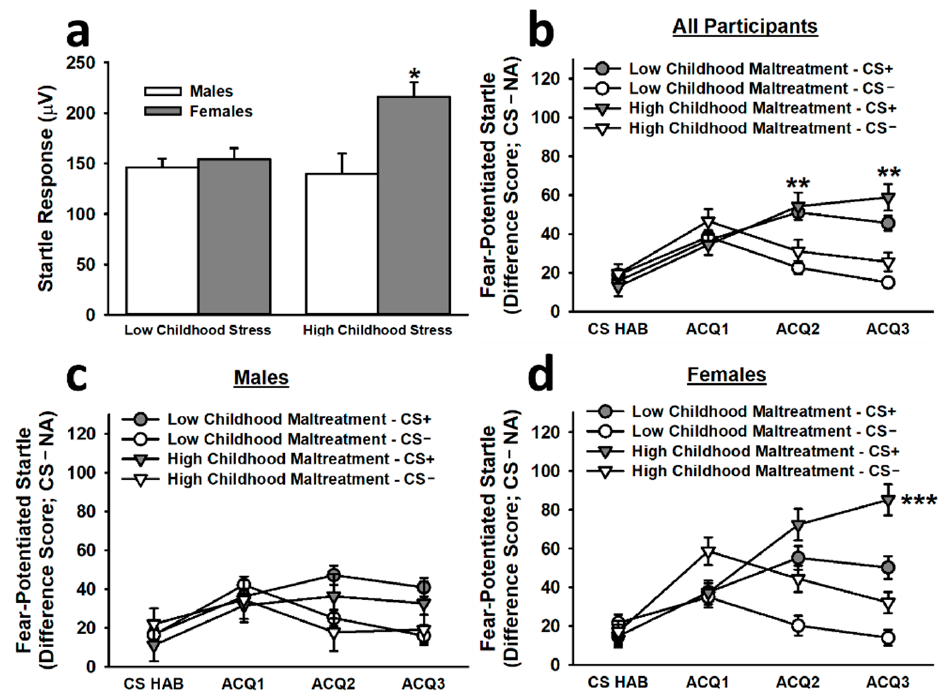
Figure 2. Baseline startle responses and fear-potentiated startle responses to the CS+ and CS − during the acquisition phase on Day 1. Females reporting high childhood maltreatment displayed significantly greater baseline startle responses than all other groups ( a ). The second inset ( b ) depicts the acquisition curve for differential fear conditioning; by the second and third blocks of reinforced acquisition trials, participants exhibited significantly greater fear-potentiated startle responses to the CS+ than to the CS − . Although both males ( c ) and females ( d ) exhibited significantly greater fear-potentiated startle responses to the CS+ than to the CS − , females reporting high childhood maltreatment demonstrated significantly greater fear-potentiated startle responses to the CS+ during late acquisition than all other groups. Data are means ± SEM. * p < 0.01 relative to all other groups; ** p < 0.001 relative to CS − . *** p < 0.01 relative to all other groups.